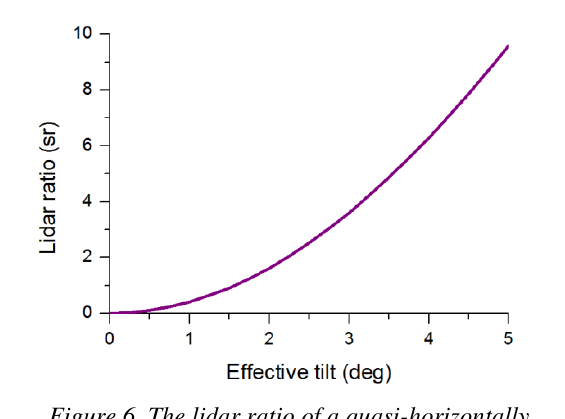
Figure 6. The lidar ratio of a quasi-horizontally oriented plate versus its effective tilt near the horizontal plane